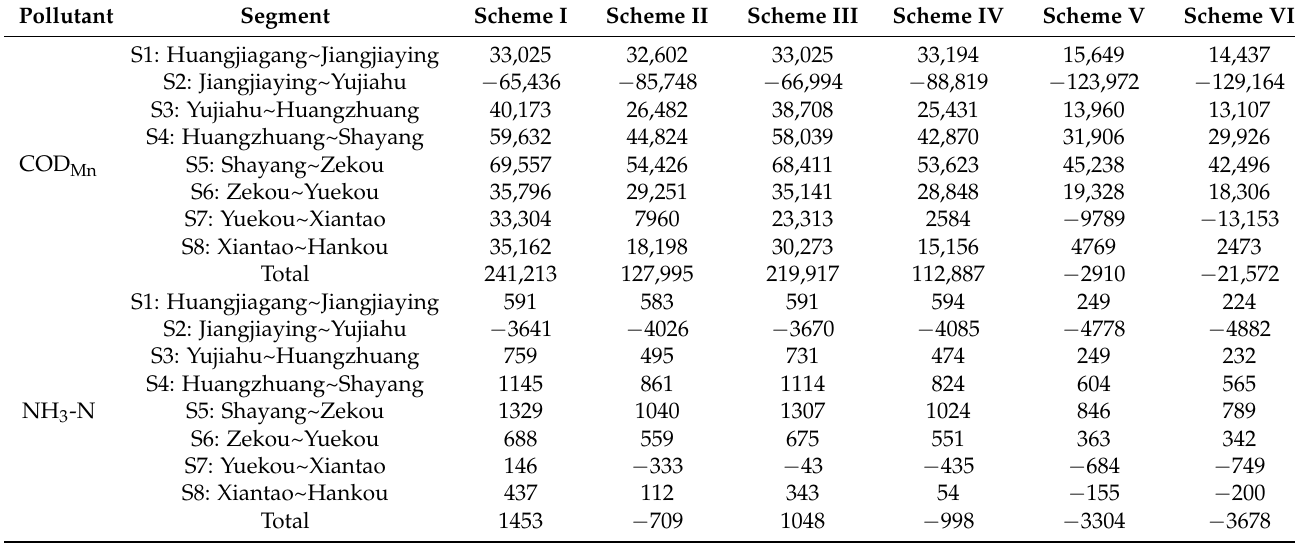
Table 9. c The permissible COD Mn and NH 3 -N in eight river segments